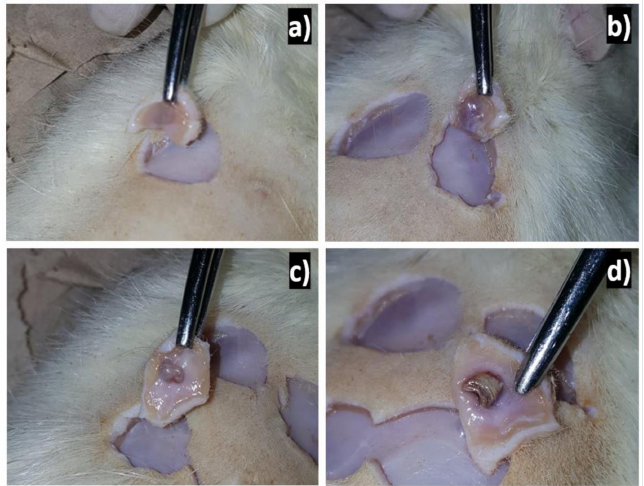
Figure 5. PCL/Ag nanofibers encapsulated in tissues of Wistar rats by a foreign body reaction 6 weeks after implantation: ( a ) 12.5 mM, ( b ) 25 mM, ( c ) 50 mM, and ( d ) 100